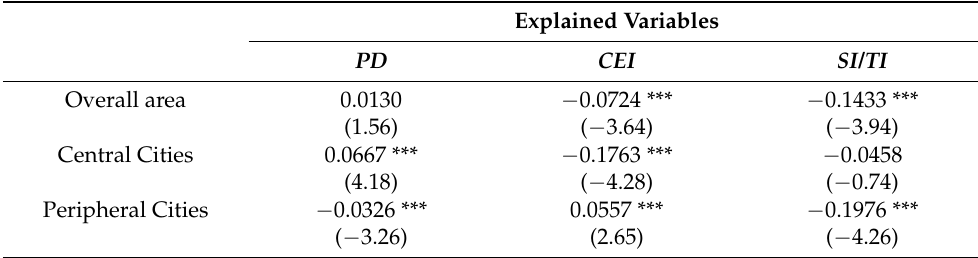
Table 7. Mechanism